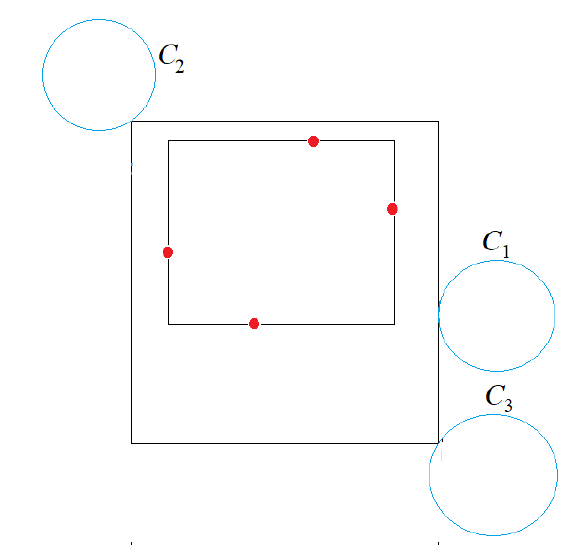
Figure 18. Case 3.2: The CSR is supported by C 1 on the east edge. One of the adjacent edges is uniquely determined, while the opposite corner may slide along a circle C 2